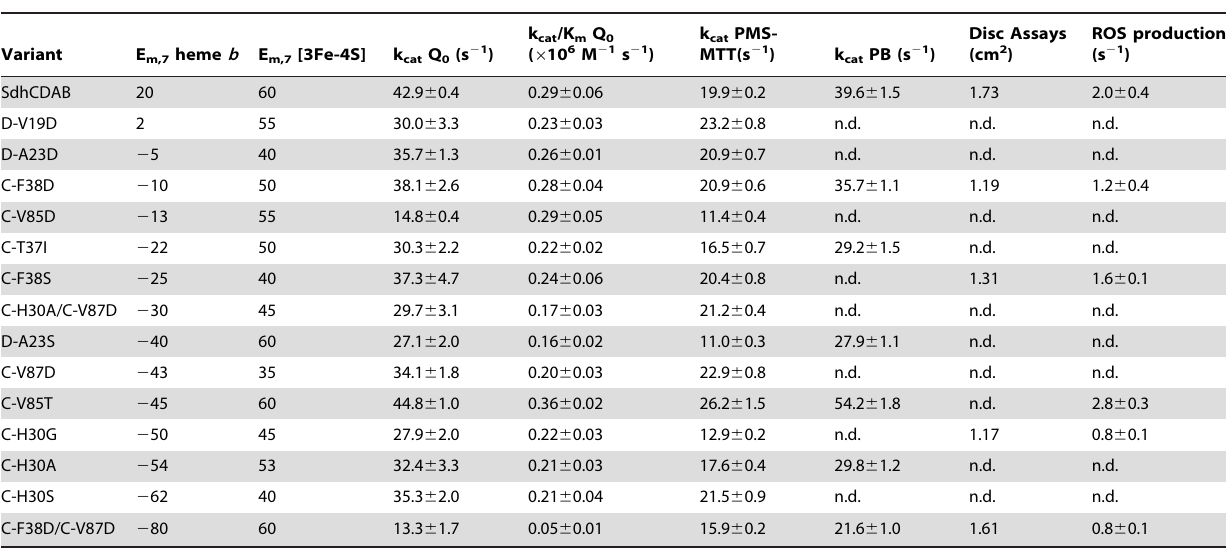
Table 1. Redox characteristics, physiological and non-physiological activity, and ROS assays of wild-type and Sdh variants.